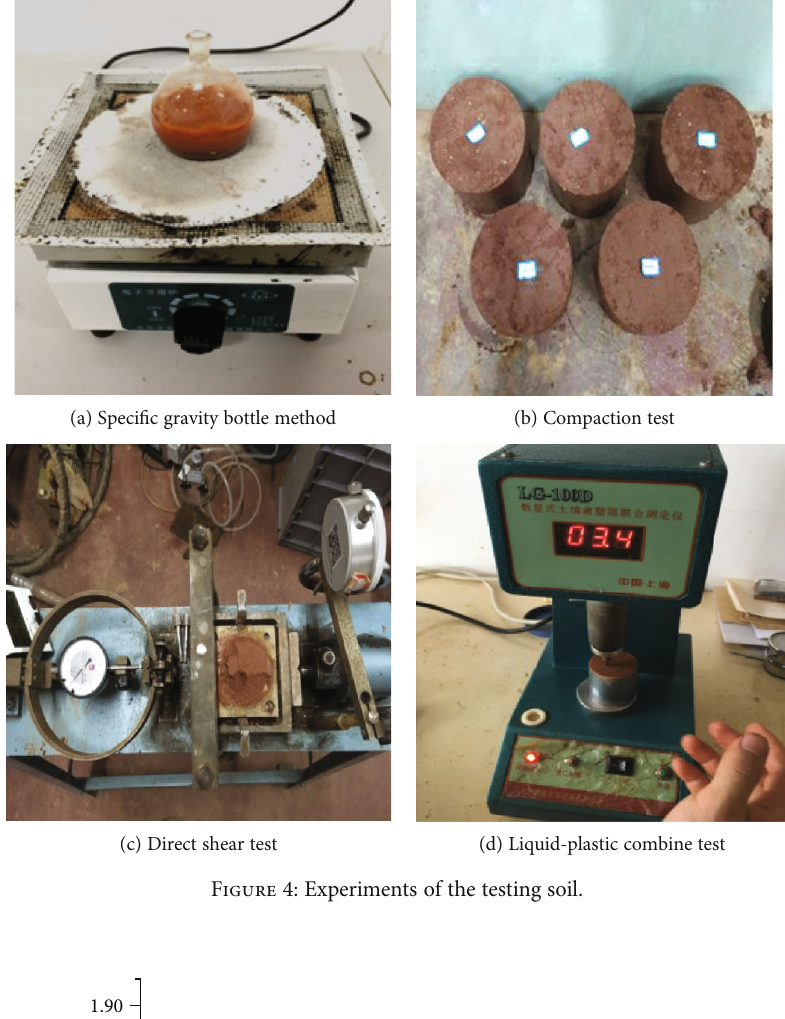
Figure 4: Experiments of the testing soil.